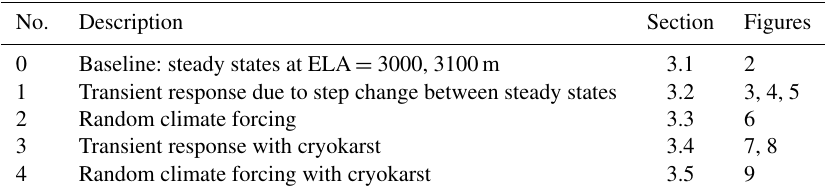
Table 1. Summary of modelling experiments performed.